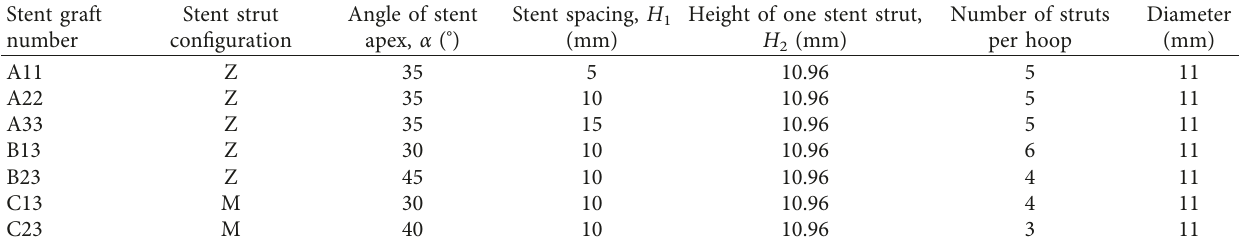
Table 2: Structural parameters of stents.